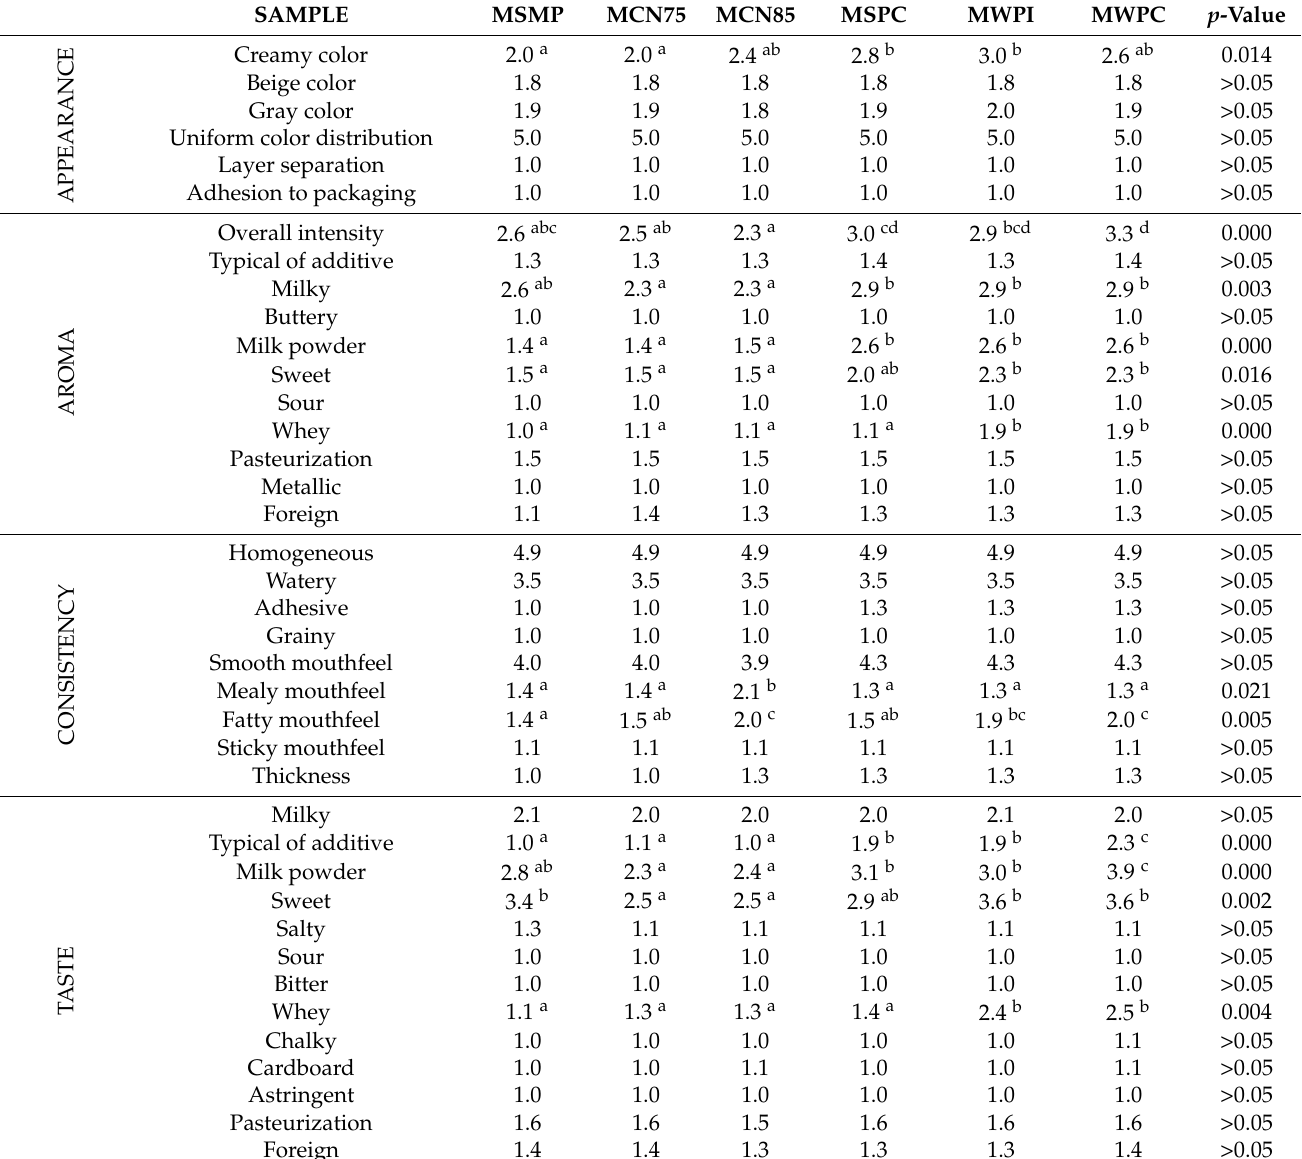
Table 6. Mean sensory scores of non-fermented milks enriched with protein